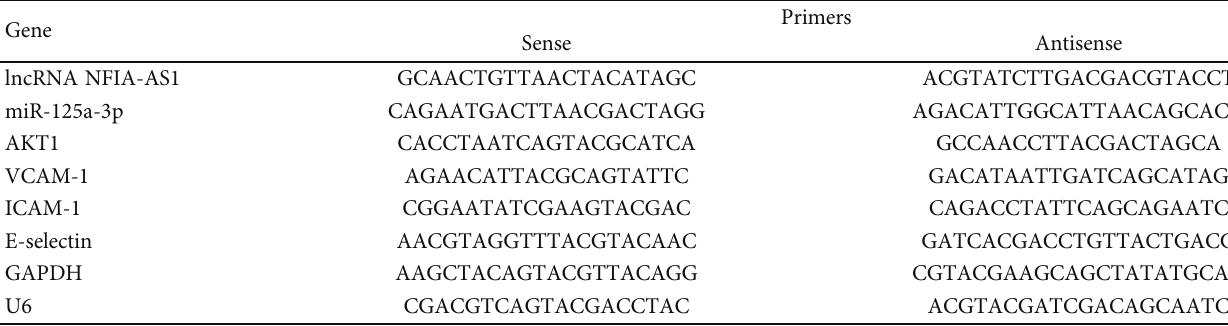
Table 1: Primers for qRT-PCR.